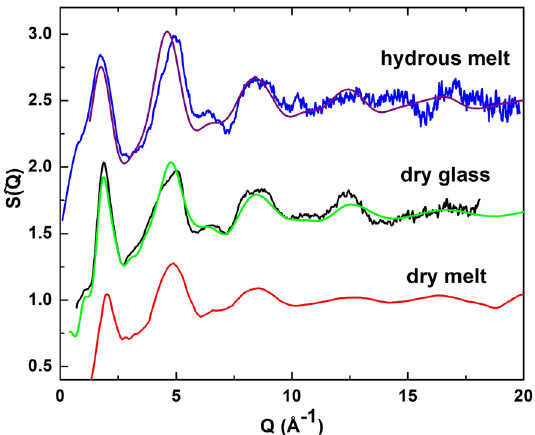
Figure 1. The experimental X-ray S(Q) structure factors for the dry albite glass (black line) and for the hydrous albite melt at 800 °C and approximately 300 MPa (blue line). Also shown are S(Q) structure factors derived from the MD simulations for the dry albite glass (green line) and for the hydrous albite melt (purple line). The experimental S(Q) for a dry albite melt measured by Yamada et al. 25 at 1500 °C and 5.3 GPa (red line) is shown here for